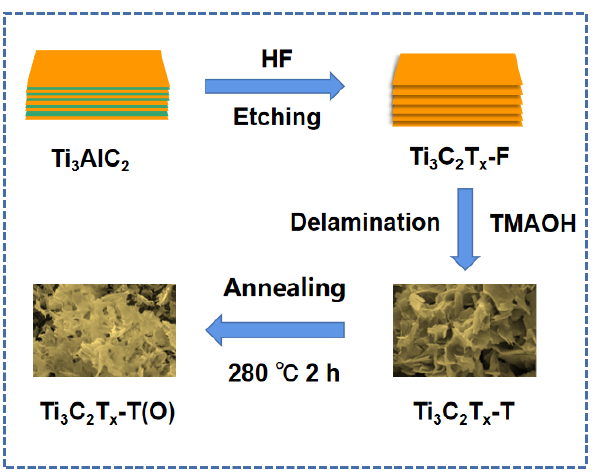
Scheme 1. The schematic illustration for the preparation of Ti 3 C 2 T x